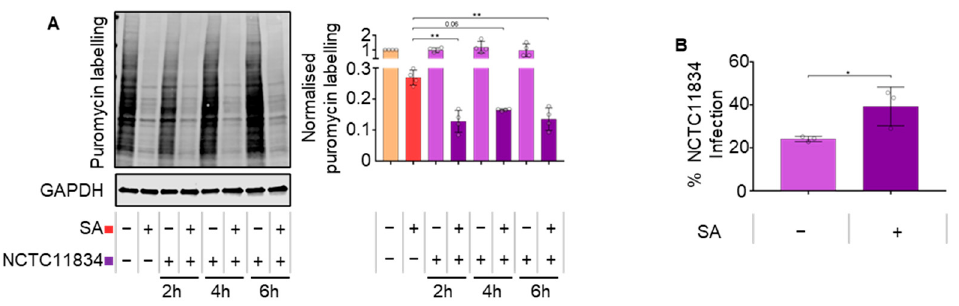
Figure 1. P. gingivalis infection heightens translational repression during oxidative stress. ( A ) Relative rate of protein synthesis in infected H357 cells following infection by P. gingivalis (NCTC11834, MOI of 100, t = 2–24 h) measured by puromycin uptake (left) and relative quantification by first normalizing to GAPDH and then to untreated sample (mean ± SD, n = 4). ( B ) Percentage of H357 cells displaying internalized antibody signal for P. gingivalis post-infection (NCTC11834, MOI of 100) after two hours (mean ± SD, n = 3). **, p ≤ 0.01; *, p ≤ 0.05 according to Kruskal–Wallis with Conover–Inman post-hoc.